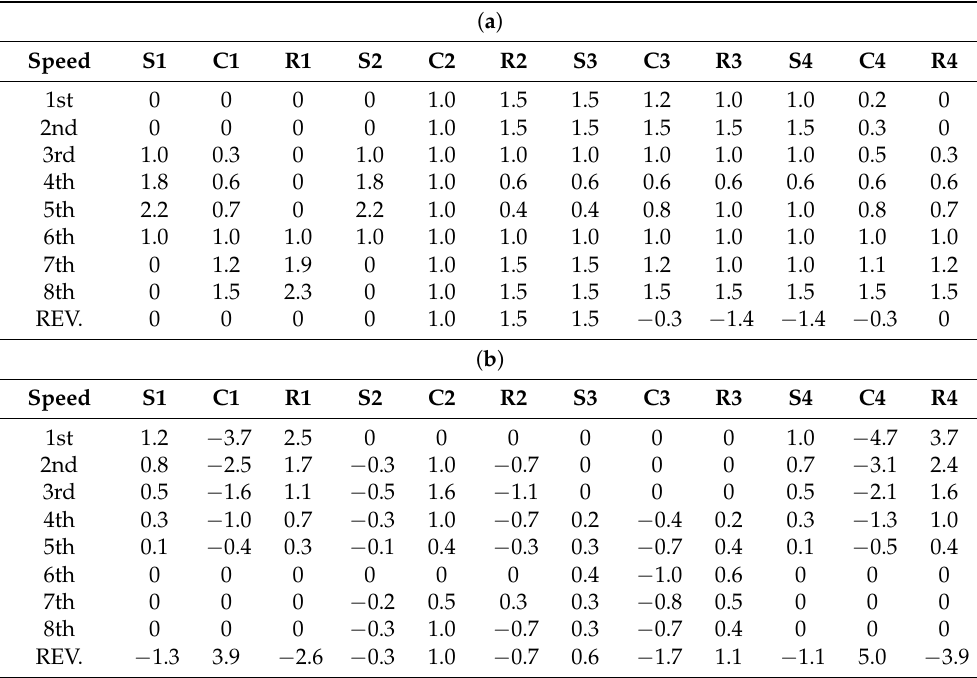
Table 2. ( a ) Rotational speed and ( b ) applied torque ratios of central members of the example planetary gear train for 8 forward and 1 reverse